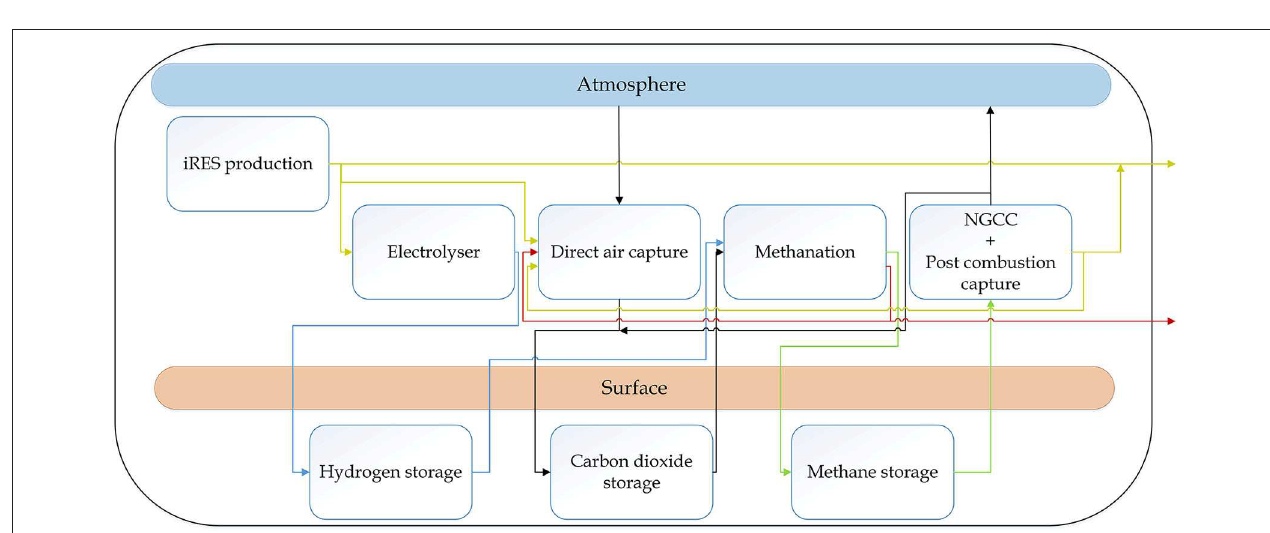
FIGURE 5 | System diagram of the P-M-P system: Yellow lines represent electricity, blue is hydrogen, black is CO 2 , green is methane and red is heat.